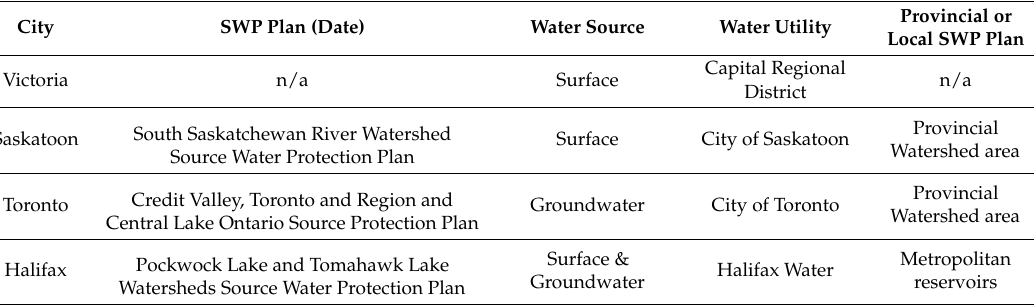
Table 1. Case study